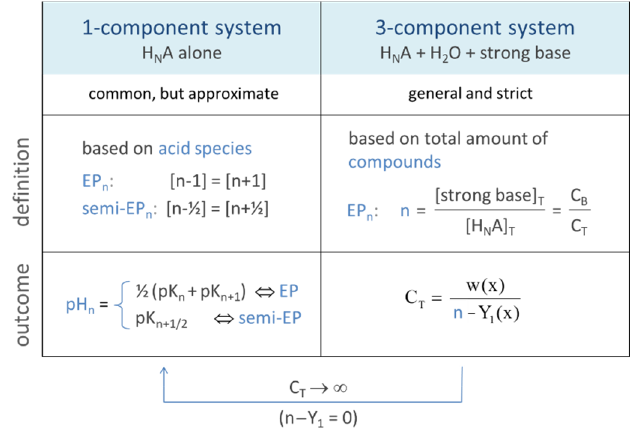
Figure 16. Two approaches to equivalence points.